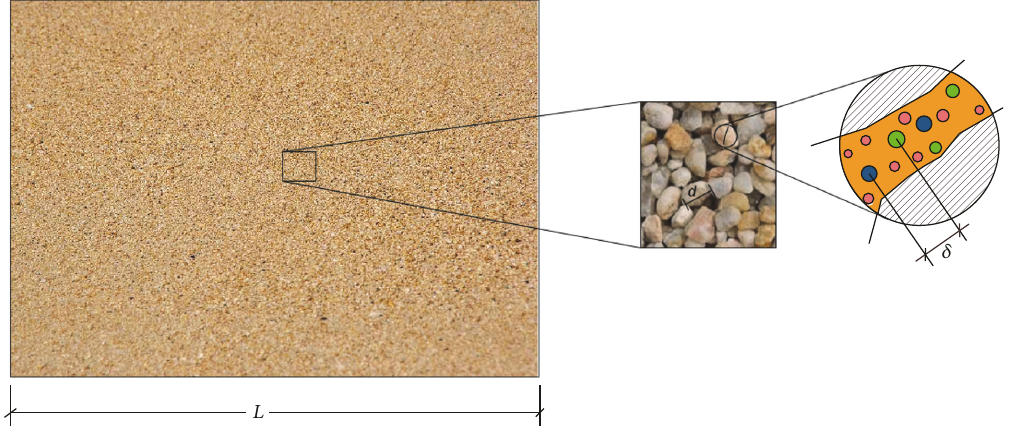
Figure 7: Porous media are rich in length scales. From scales that span several tens of kilometers to several tens of nanometers, a unified framework may be difficult to encounter phenomena occurring at such large spectrum of length scales. Every scale has its relevant variables that are, generally, different than respective variables at different scales. Upscaling is necessary to communicate relevant data between different